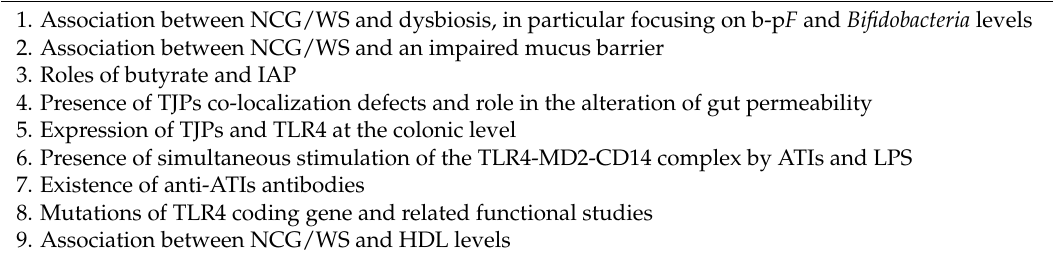
Table 1. Starting points for research. The listed starting points are suggested for testing our hypothesis on the pathogenic mechanism of non-coeliac gluten/wheat sensitivity (NCG/WS). b-p F = butyrate-producing Firmicutes, IAP = intestinal alkaline phosphatase, TJPs = tight junctions proteins, TLR4 = toll-like receptor 4, ATIs = amylase trypsin inhibitors, LPS = lypopolysaccharide, HDL=high density